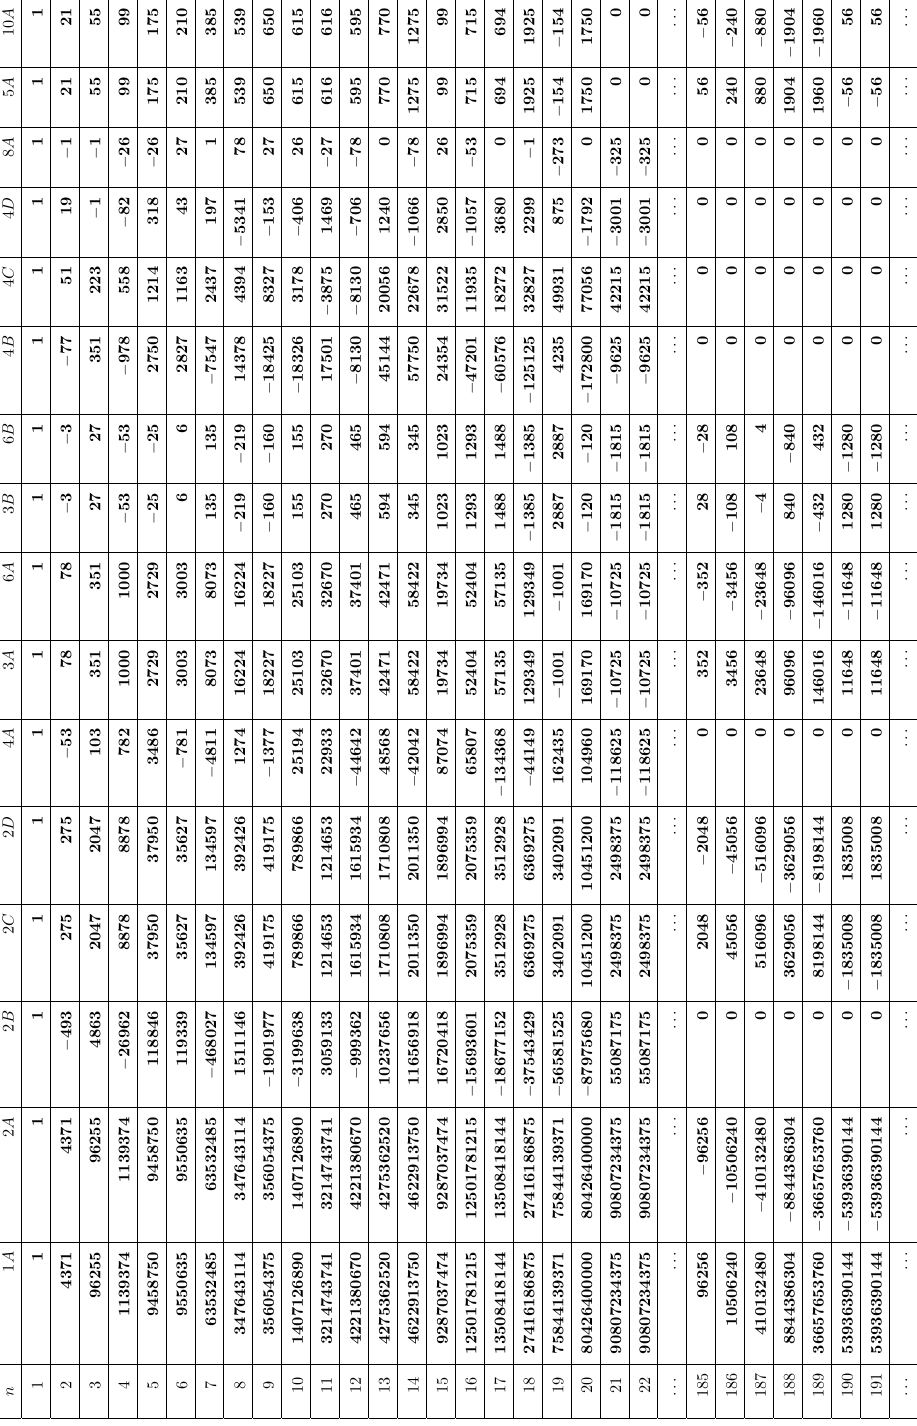
Table 2 . Partial character table of the baby Monster group 2 (cid:1) B